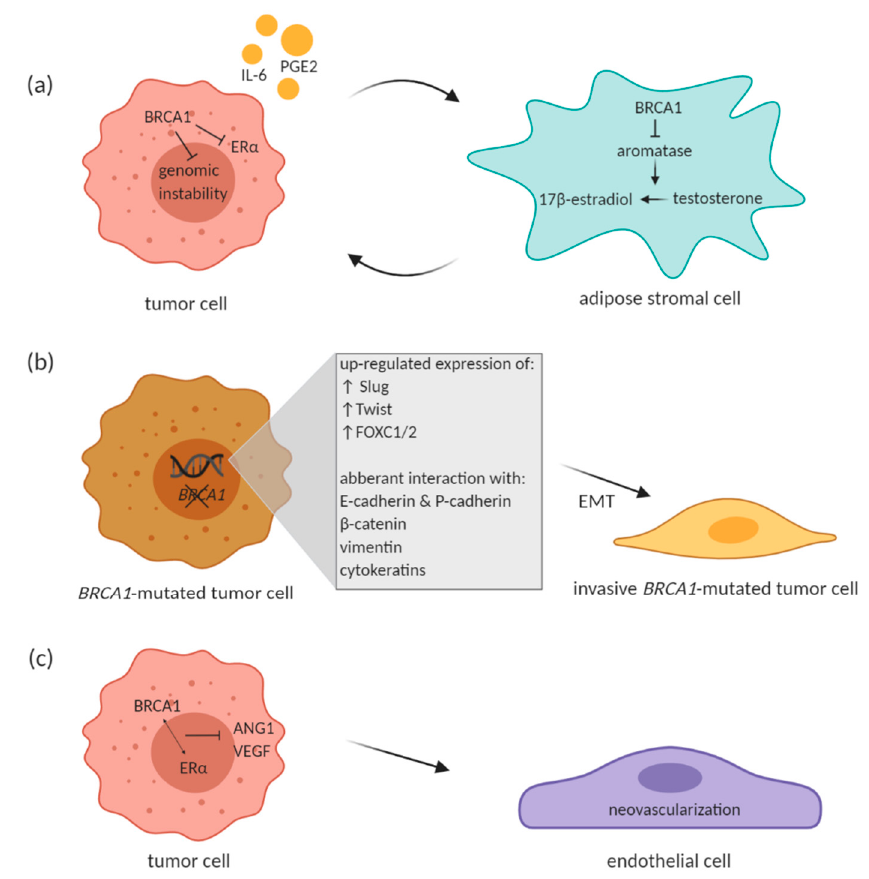
Figure 1. Proposed effect of BRCA1 on different cells in the tumor microenvironment (TME). ( a ) Paracrine loop between BRCA1-proficient breast tumor cell and adipose stromal cell. ( b ) BRCA1 mutation leads to enhanced EMT phenotype. ( c ) Effect of BRCA1 on endothelial cells within the TME. BRCA1 in interaction with estrogen receptor α (ER α ) has been shown to inhibit VEGF and angiopoetin-1 (ANG1) transcription. Created with BioRender.com.